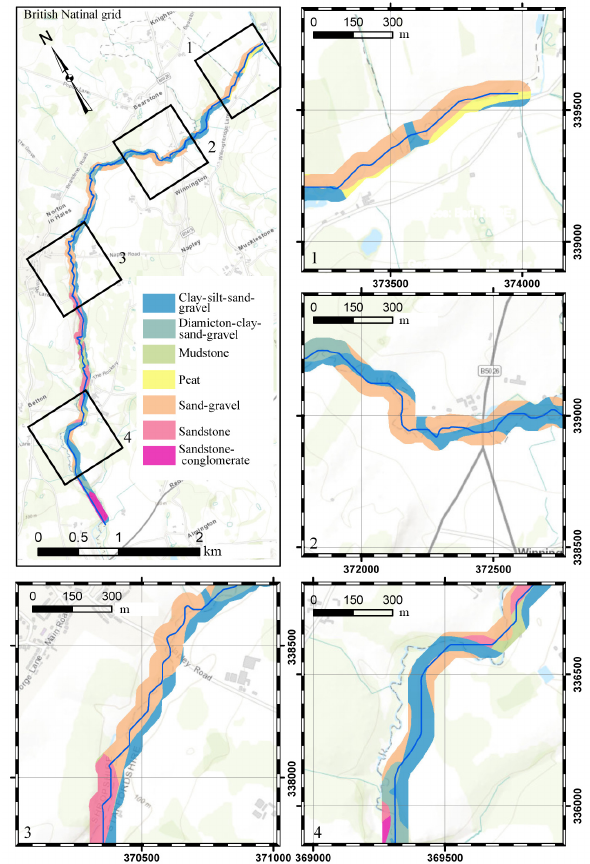
Figure 5. Examples of reaches of the River Tern analysed for HEF (Table 2). The river is subdivided into reaches based on their plan- form morphology (sinuosity units: when the overall direction of the planimetric course changes) and classified in Table 2. The fig- ure represents for each reach the main river and the surficial and bedrock geology in a buffer area of 50m from the main channel. Surficial and bedrock geology are represented as greater than the connectivity within sediment strata and higher the HEF. Vertical HEF will be restricted by low permeability units and unconsolidated deposits and lateral HEF by grain size material, river sinuosity, and cross-valley head